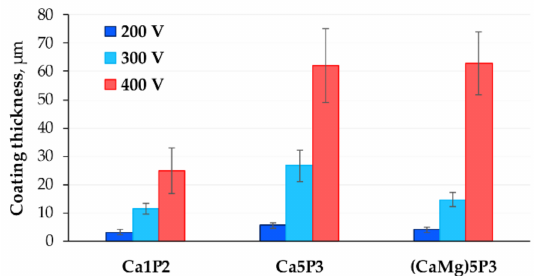
Figure 4. Average thicknesses of the PEO coatings formed on